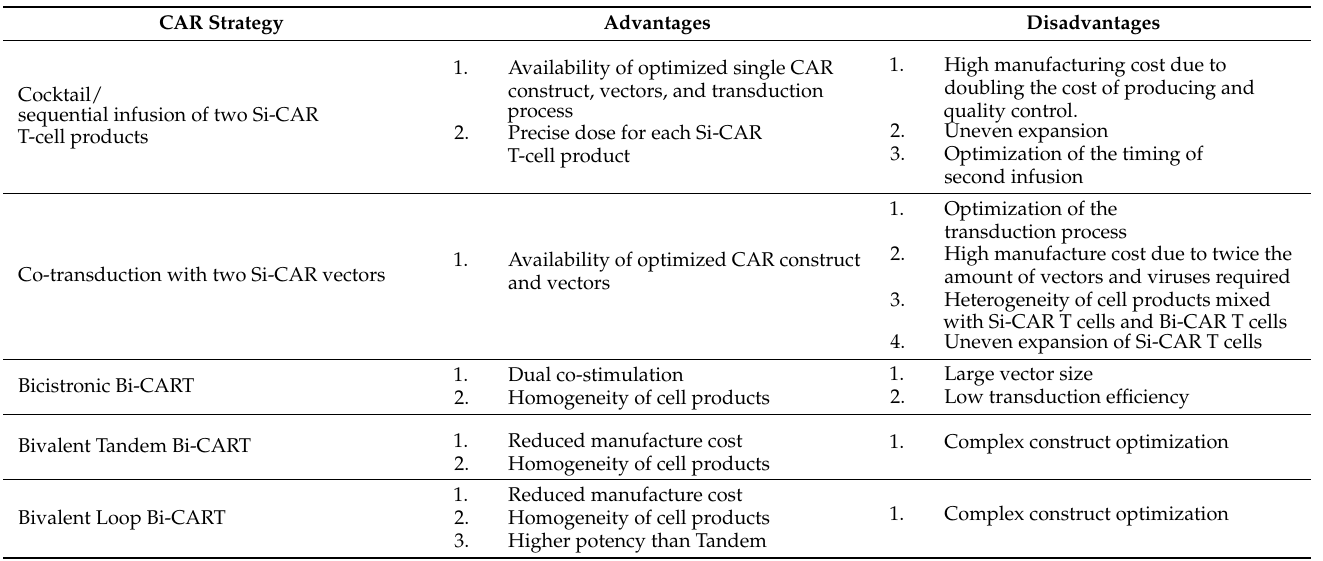
Table 1. Advantages and disadvantages of common dual CAR